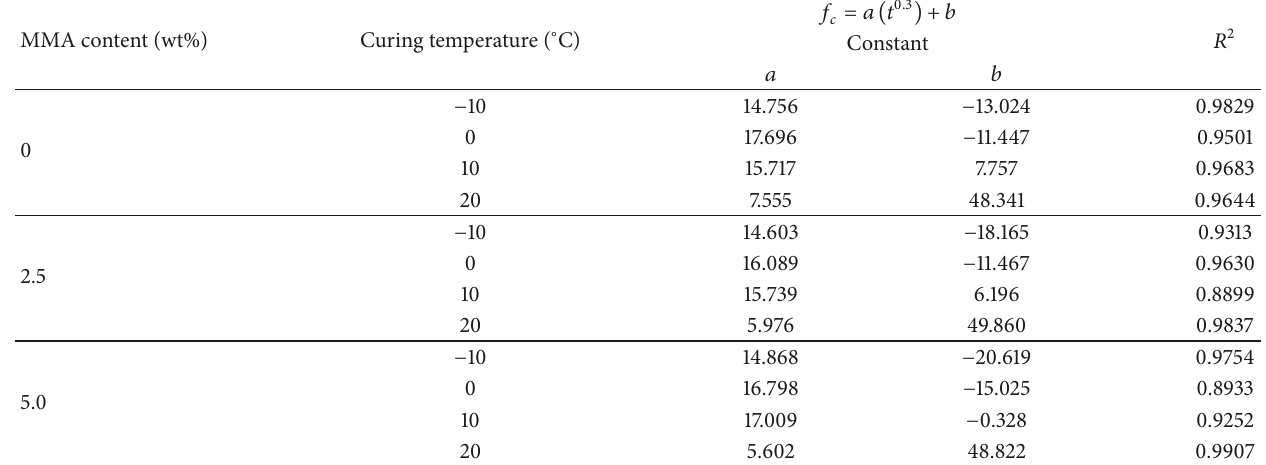
Table 10: Computation results of the slope coefficient of strength ( 𝑛 = 0.3 ).